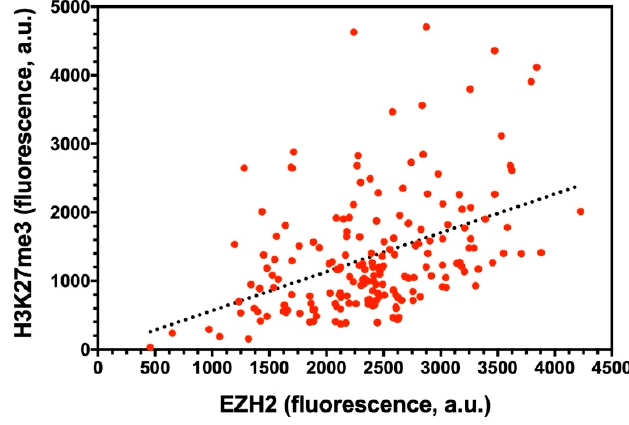
Figure 5. H3K27me3 vs. EZH2 nuclear fluorescence plot. Each red circle stands for a single nucleus. The black line represents the linear fitting of data and was drawn only to highlight the presence of a stoichiometric correlation between the two partners.